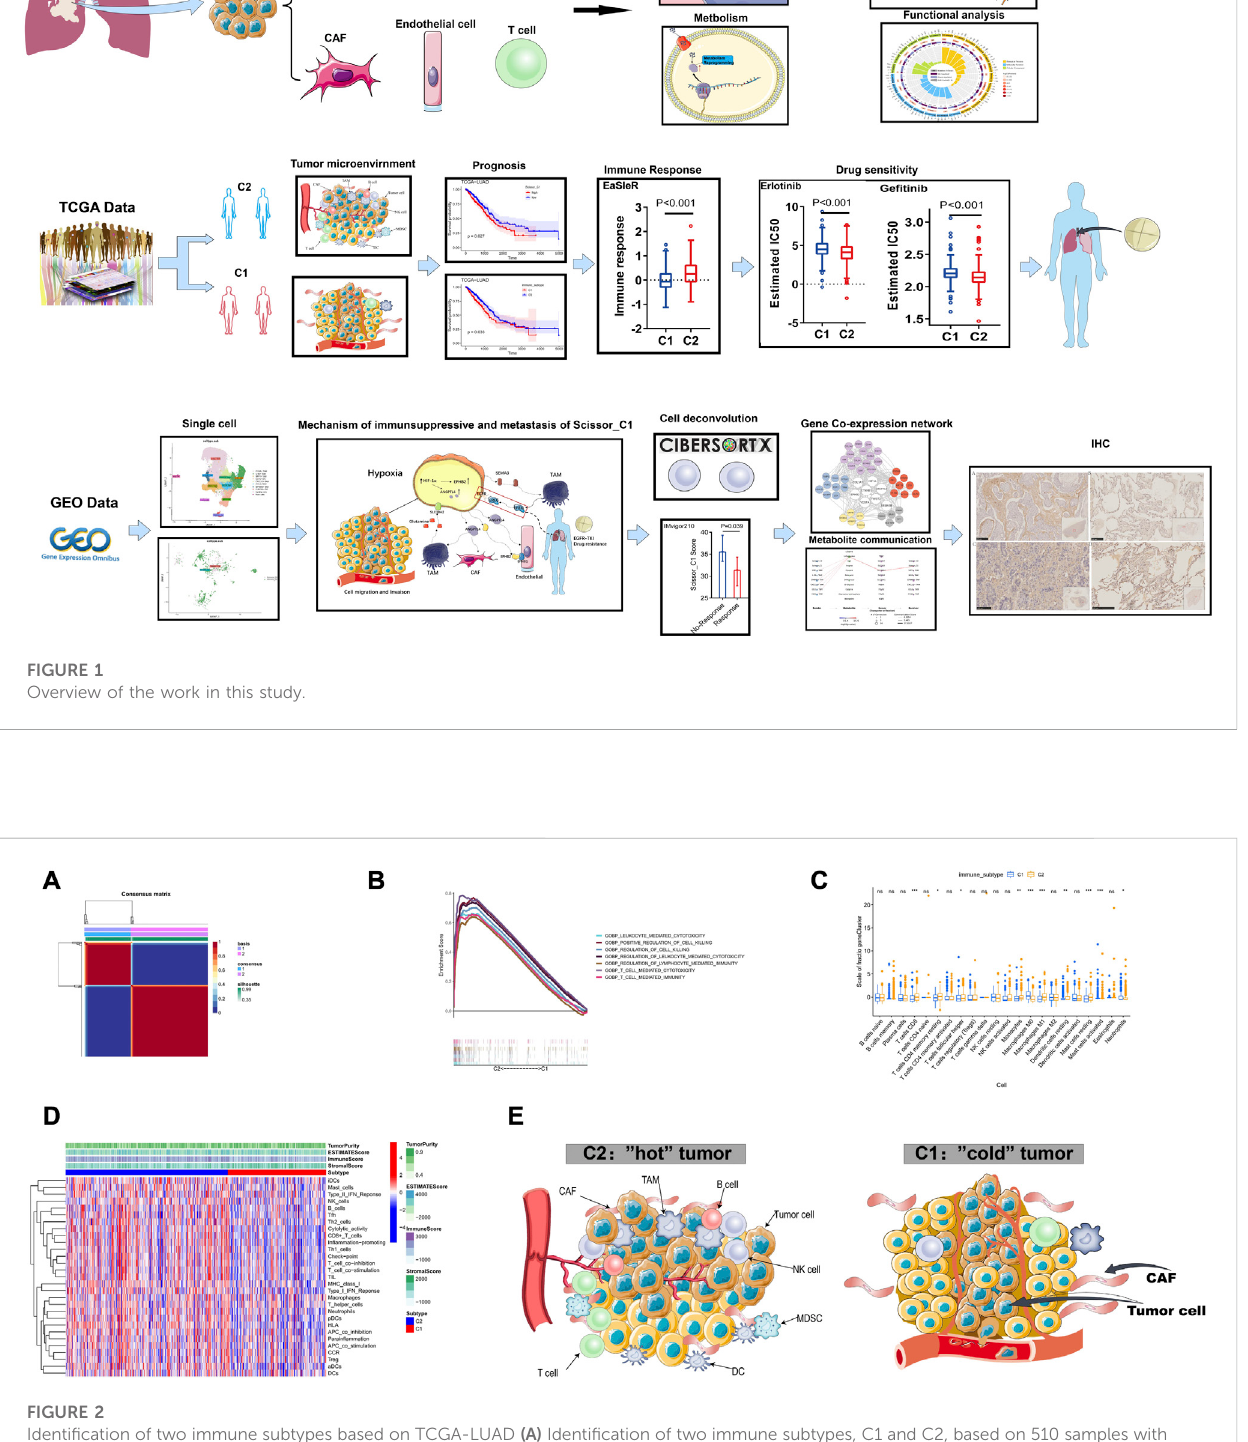
Frontiers in Cell and Developmental